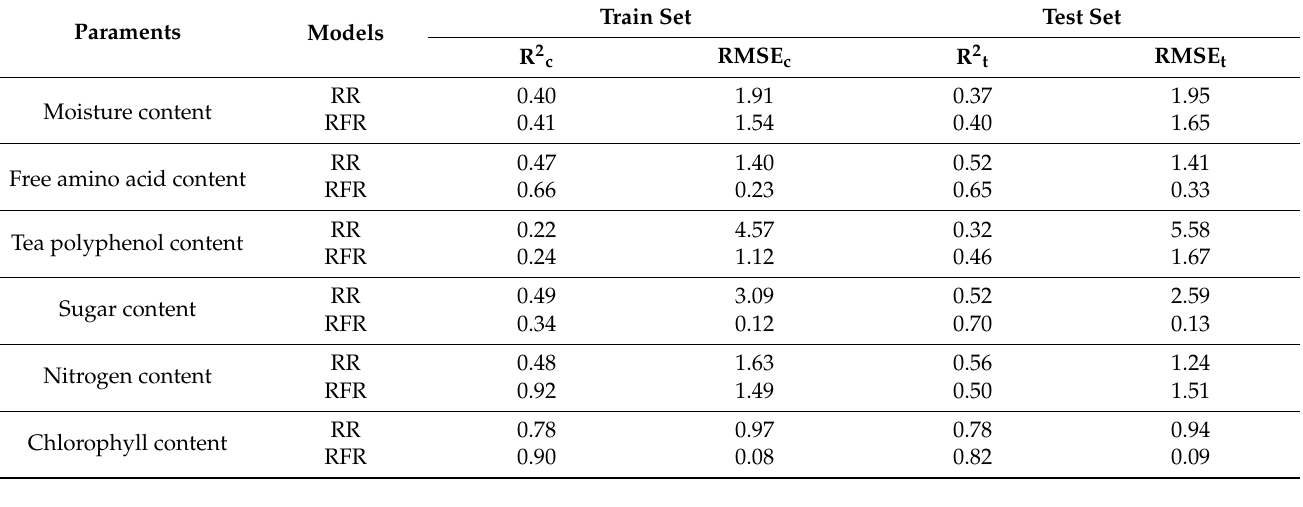
Table 5. Evaluation index scores of ridge regression model (RR) and random forest model (RFR).